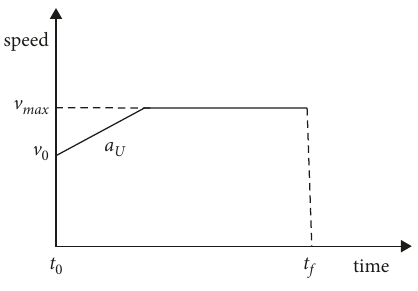
Figure 6: Speed trajectory with minimum travel